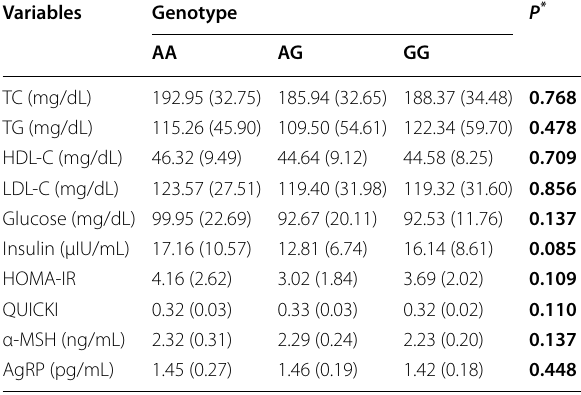
Table 4 The associations of CARTPT rs2239670 polymorphism and biochemical parameters